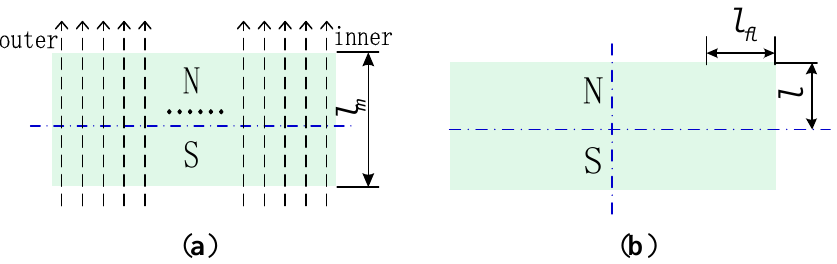
Figure 9. PM. ( a ) ideal MFL of the PM. ( b ) size of the PM.